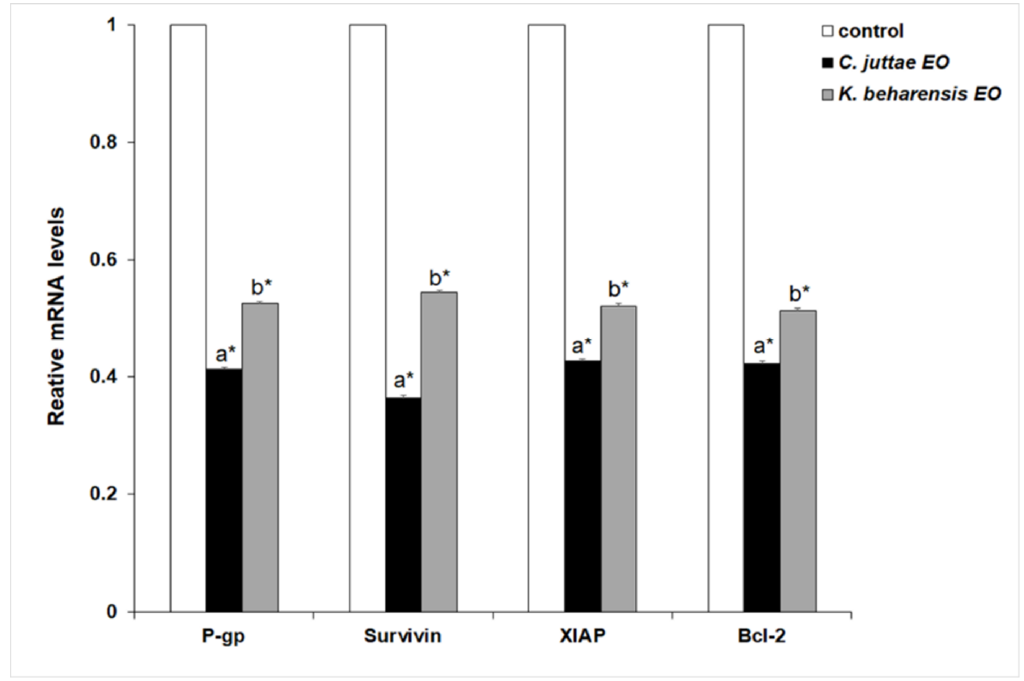
Figure 8. Genes mRNA expression levels by quantitative polymerase chain reaction in HL-60 R cells.